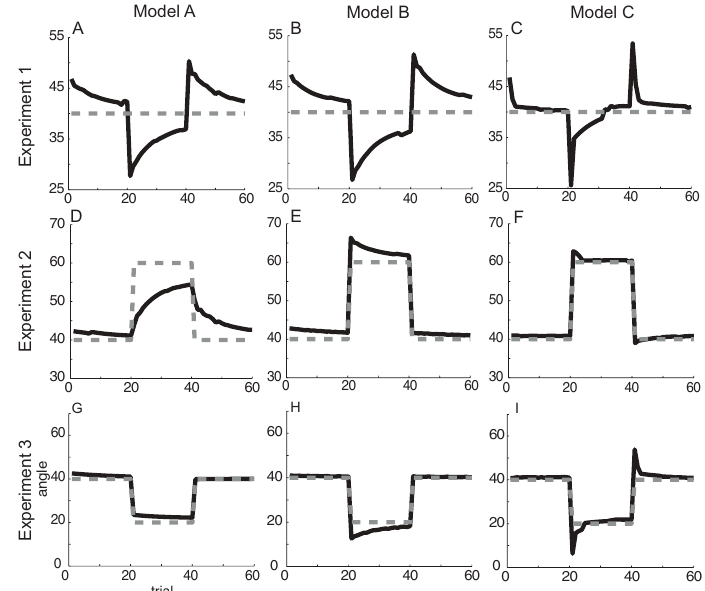
Figure 4. Results from one simulation run of each model. Results plotted are the initial angle (in degrees) of the simulated movement observed on screen against the trial number in that experiment. The solid black line represents the computer simulation results; whereas the dotted grey line represents the target presented for that trial. Experiment 4 was not simulated due to the nature of the experiment being very similar to experiment 3. To a computer simulation, experiment 3 and experiment 4 are the same as the difference between the two experiments comes from difference in visual display. The first column ( A , D , G ) are the results from model A , second column ( B , E , H ) are results from model B and the third column ( C , F , I ) are from model C . The first row ( A , B , C ) are results for experiment 1, the second row ( D , E , F ) are results for experiment 2, and the third row ( G , H , I ) are results for experiment